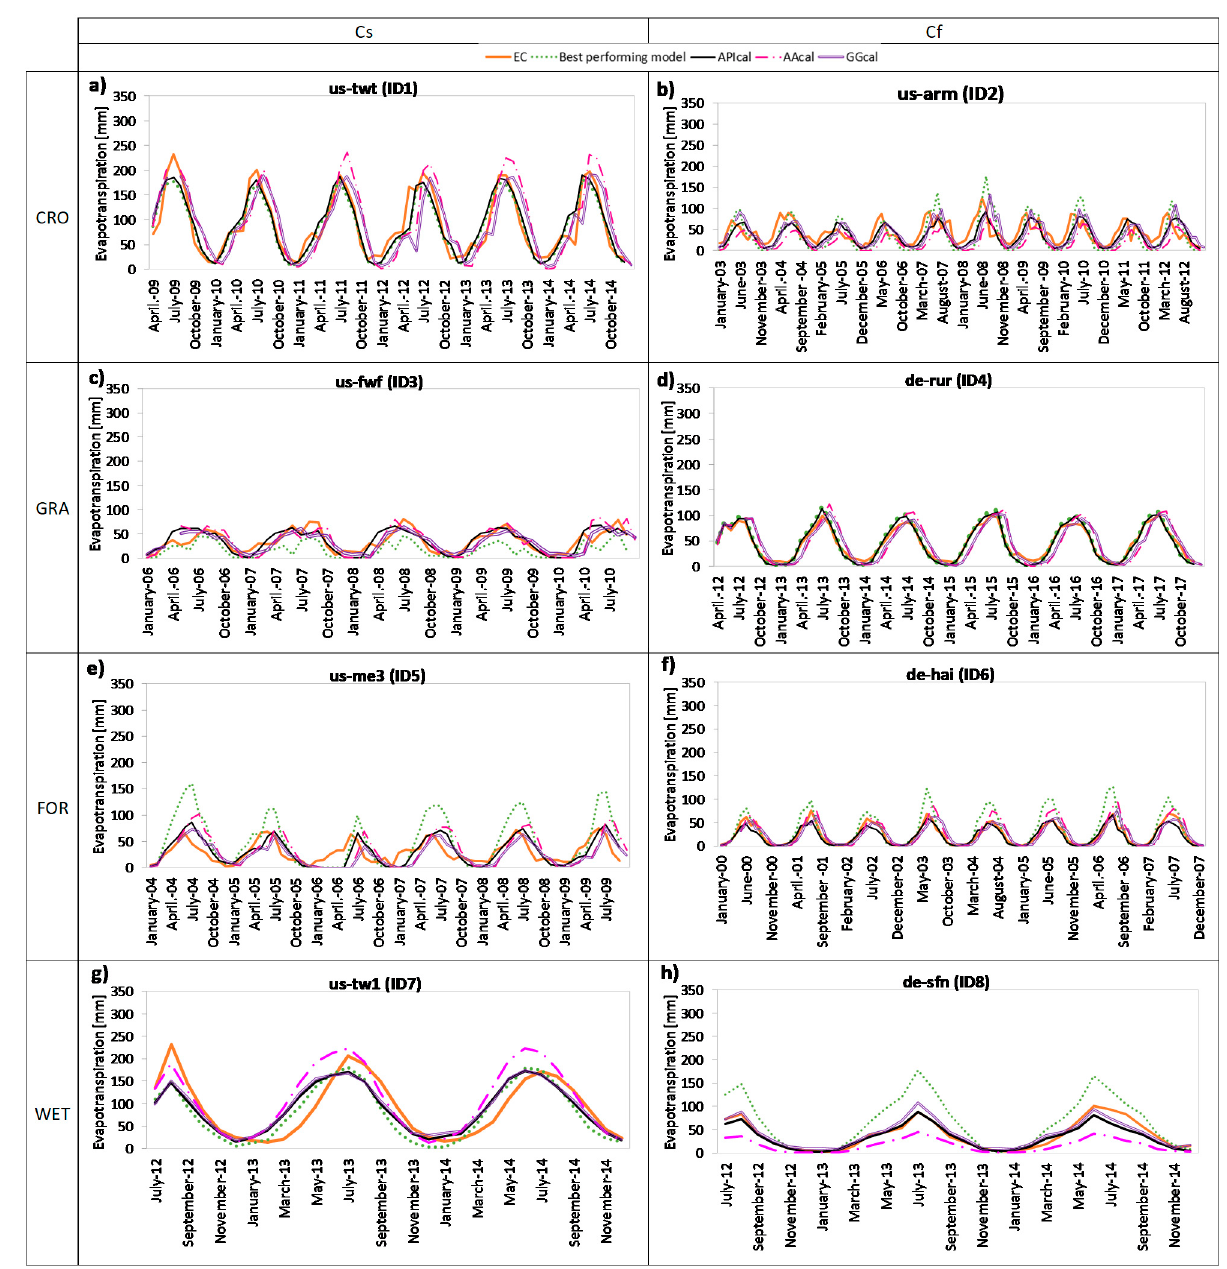
Figure 6. Monthly patterns of measured evapotranspiration fluxes and of modelled ones obtained by the calibrated models and by the most accurate non-calibrated approach for each of the selected site: ( a ) us-twt, ( b ) us-arm, ( c ) us-fwf, ( d ) de-rur, ( e ) us-me3, ( f ) de-hai, ( g ) us-tw1, ( h ) de-sfn. The relative difference in RMSE, r, and d before and after the calibration procedure as shown in Figure 7, allows to observe that the error decreases due to this process indeed, when the difference in RMSE is positive, the model performances improve and vice versa for d and r.